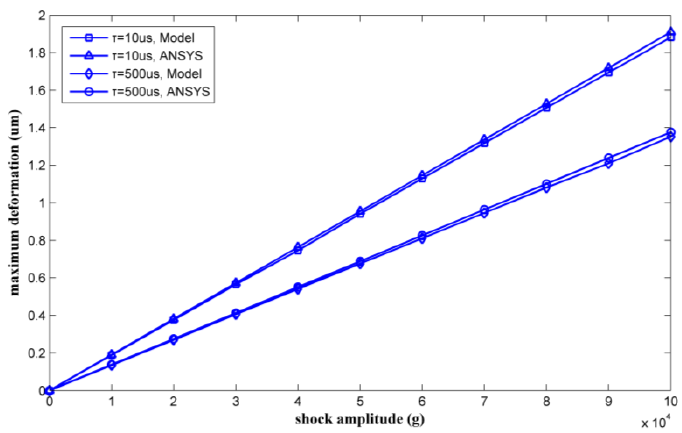
Figure 15. Maximum Von Mises equivalent stress as calculated by ANSYS and the proposed model versus shock load amplitude.